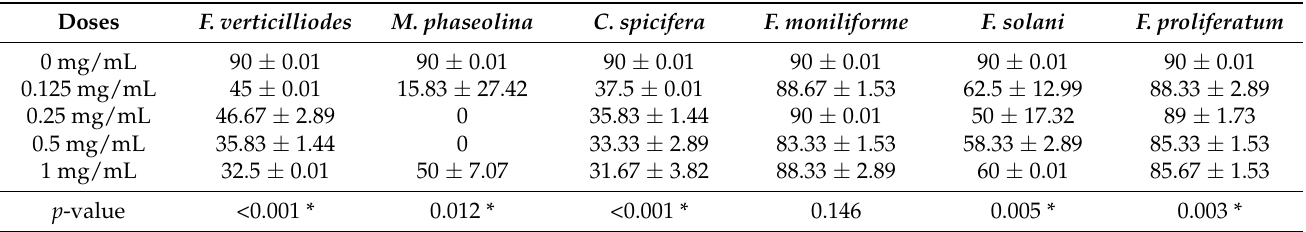
Table 3. Effect of different concentrations of Ridomol on growth of different phytopathogenic fungi. Doses